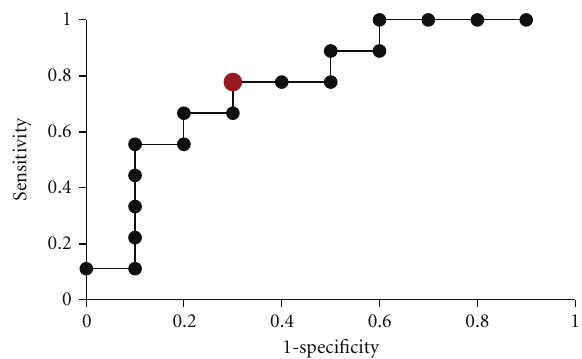
Figure 6: ROC curve analysis of diagnostic accuracy of sputum PPD-induced IFN γ . The sensitivity and specificity for discrimi- nating active TB from non-active TB, at a diagnostic threshold of PPD-induced gamma interferon production by 1.2% of total lymphocytes (larger red point), were 78% and 70%, respectively, yielding positive and negative predictive values of 70% and